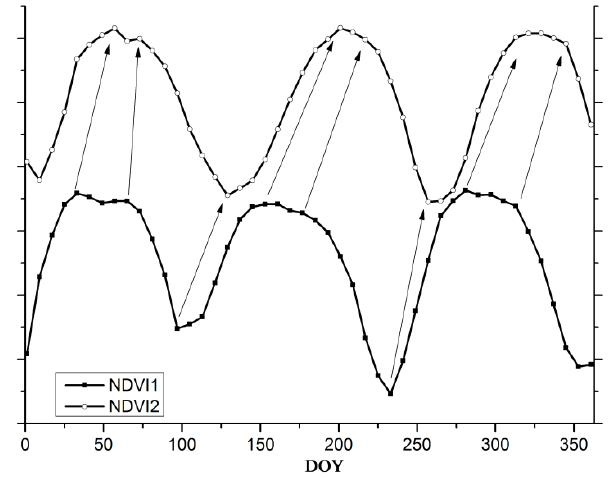
Figure 5. Illustration of DTW-corrected distances. The NDVI2 cycle’s planting date is later than that of the NDVI1 cycle.